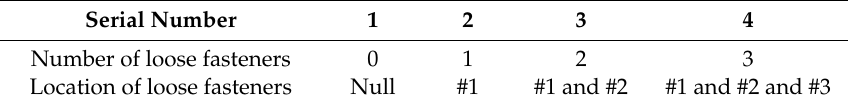
Table 3. Operating conditions of damage location identification.